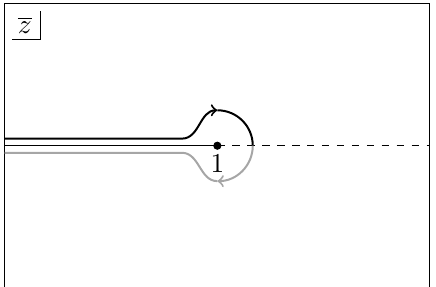
Figure 7. Trajectory of z near the boundary between the first and the second